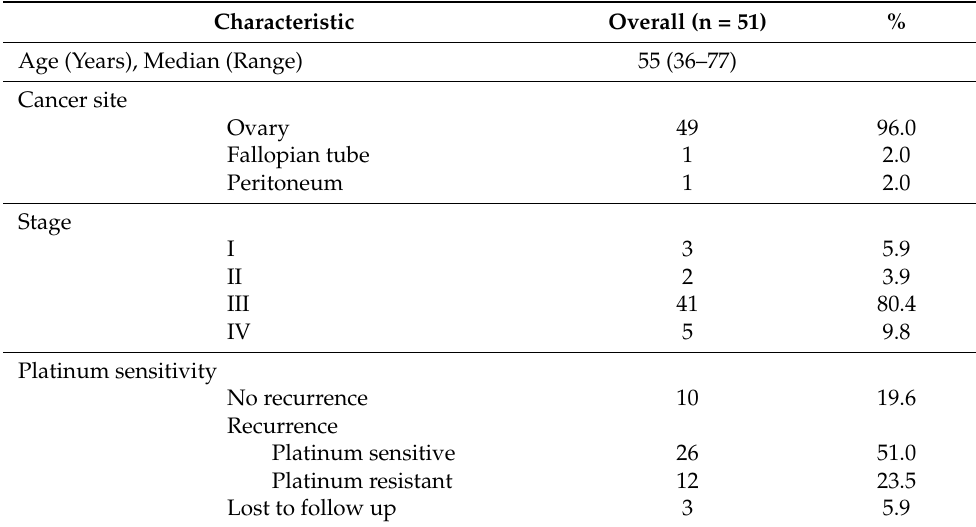
Table 1. Clinical characteristics of 51 patients with HGSC in our study. Characteristic Overall (n = 51) % Age (Years), Median